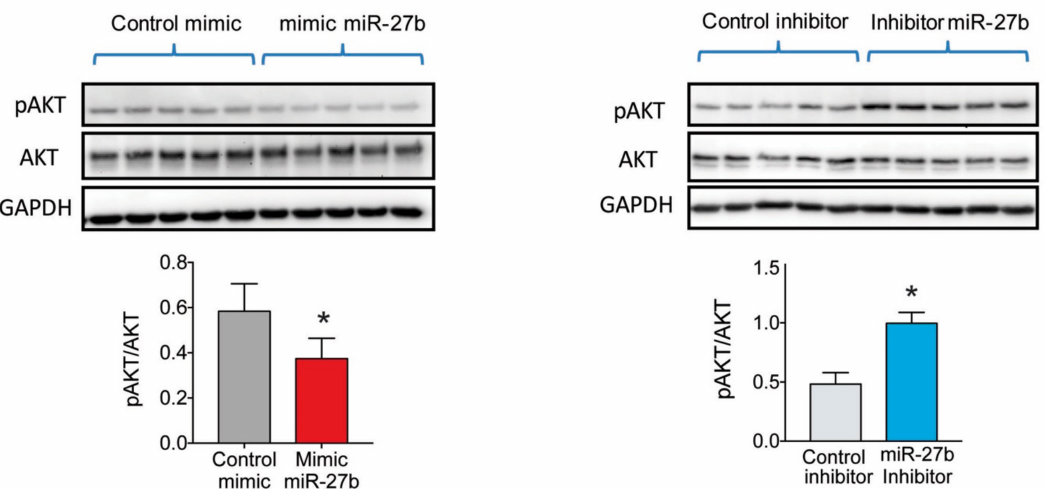
Figure 3. miR-27b levels regulate insulin signaling and attenuates AKT2 phosphorylation in Huh7 cells. Western blot analysis of AKT2 phosphorylation in Huh7 cells treated with miR-27b mimic or miR-27b inhibitor and their respective controls. * p < 0.05 (significantly di ff erent from cells transfected with the CM or CI). Data are presented as the mean SEM. n = 3 independent experiments. Western blot ± images correspond to results from a representative experiment among three that gave similar